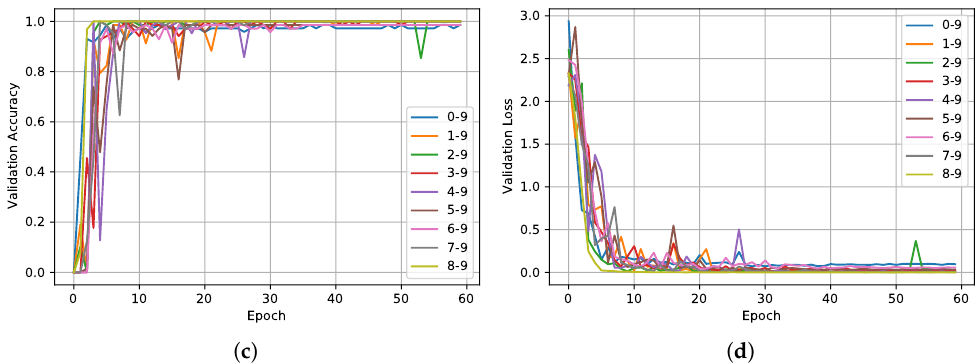
Figure 8. Metrics used to demonstrate the goodness of fitting: ( a ) training accuracy, ( b ) training loss, ( c ) validation accuracy, ( d ) validation loss.